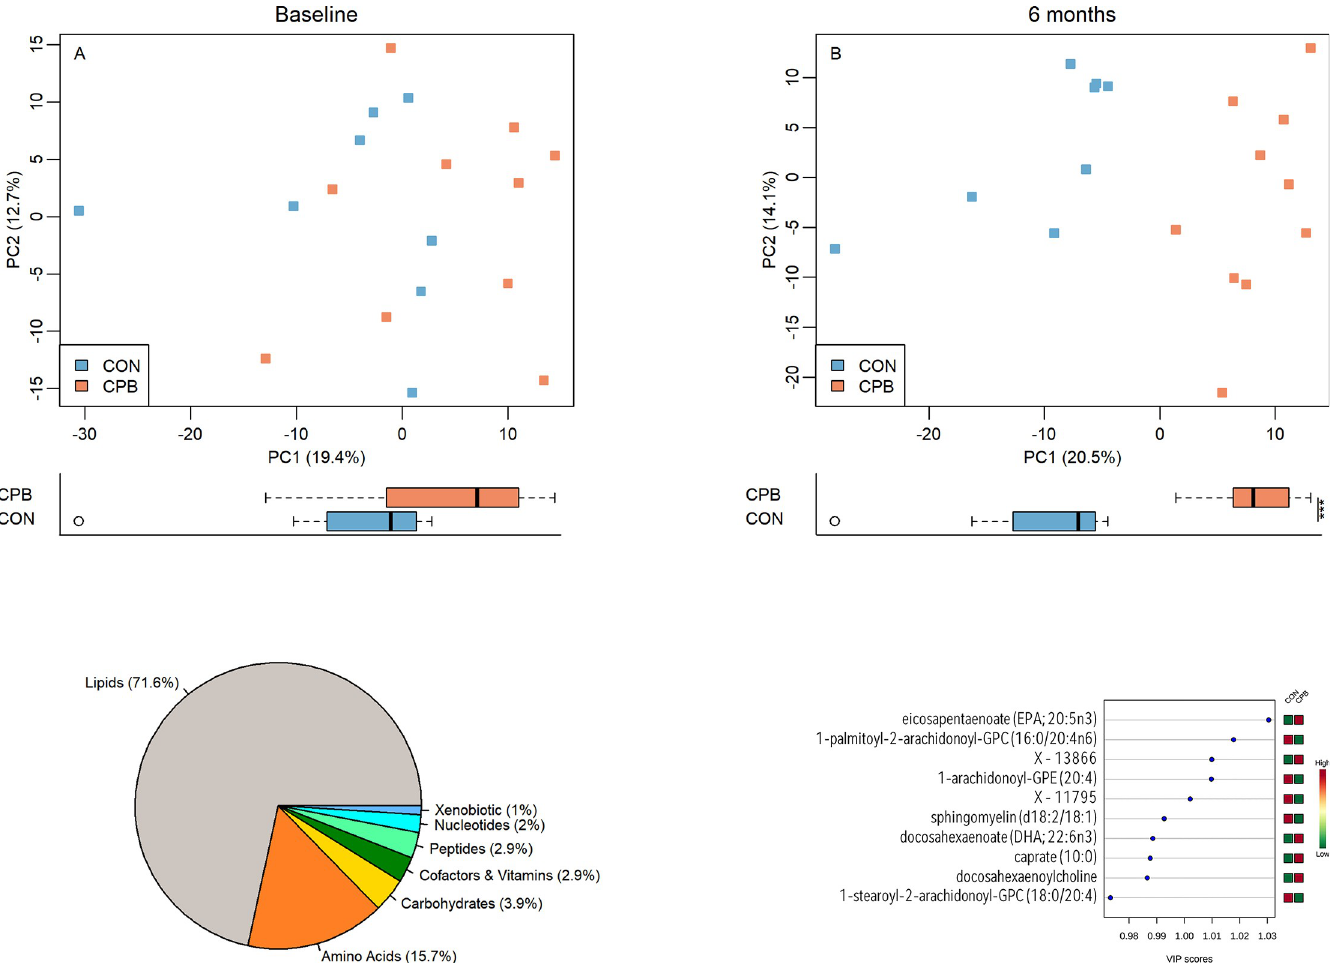
Fig 1. (A, B) Principal component analysis (PCA) based on diet effects at baseline (A) and 6 months (B). The percentages of data variation explained by the first two principal components, PC1 and PC2, are indicated on the x and y axes respectively. Distributions of samples along PC1 by diets were plotted below each PCA plot. Blue squares represent CON diet while orange ones represent CPB diet. � P < 0.05; �� P < 0.01; ��� P < 0.001. (C) Pie chart shows percentage of each metabolite class. (D) Partial least squares discriminant analysis (PLS-DA) identified ten metabolites with the highest Variable Importance in Projection (VIP) scores, which indicates discriminant power between